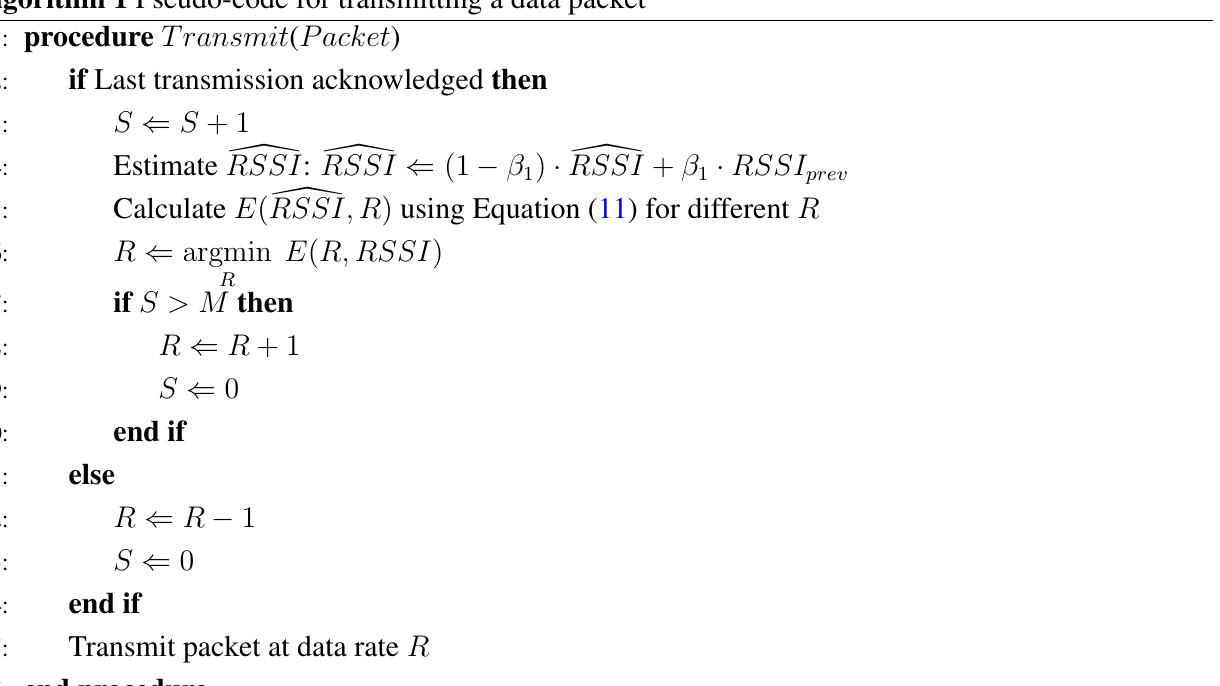
Algorithm 1 Pseudo-code for transmitting a data